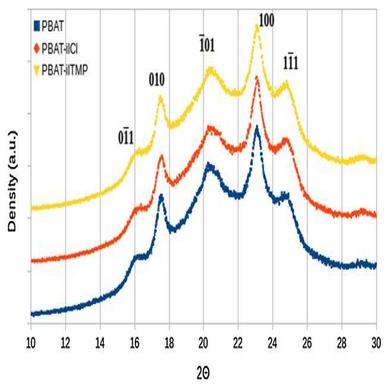
WAXS scans of neat PBAT and PBAT/ILs blends. Each peak corresponds to a PBT crystalline direction, according to the study of Briber and Thomas .